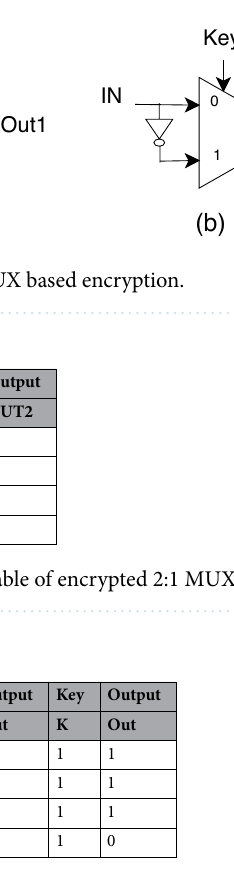
Table 2. Truth table for XOR encrypted circuit.